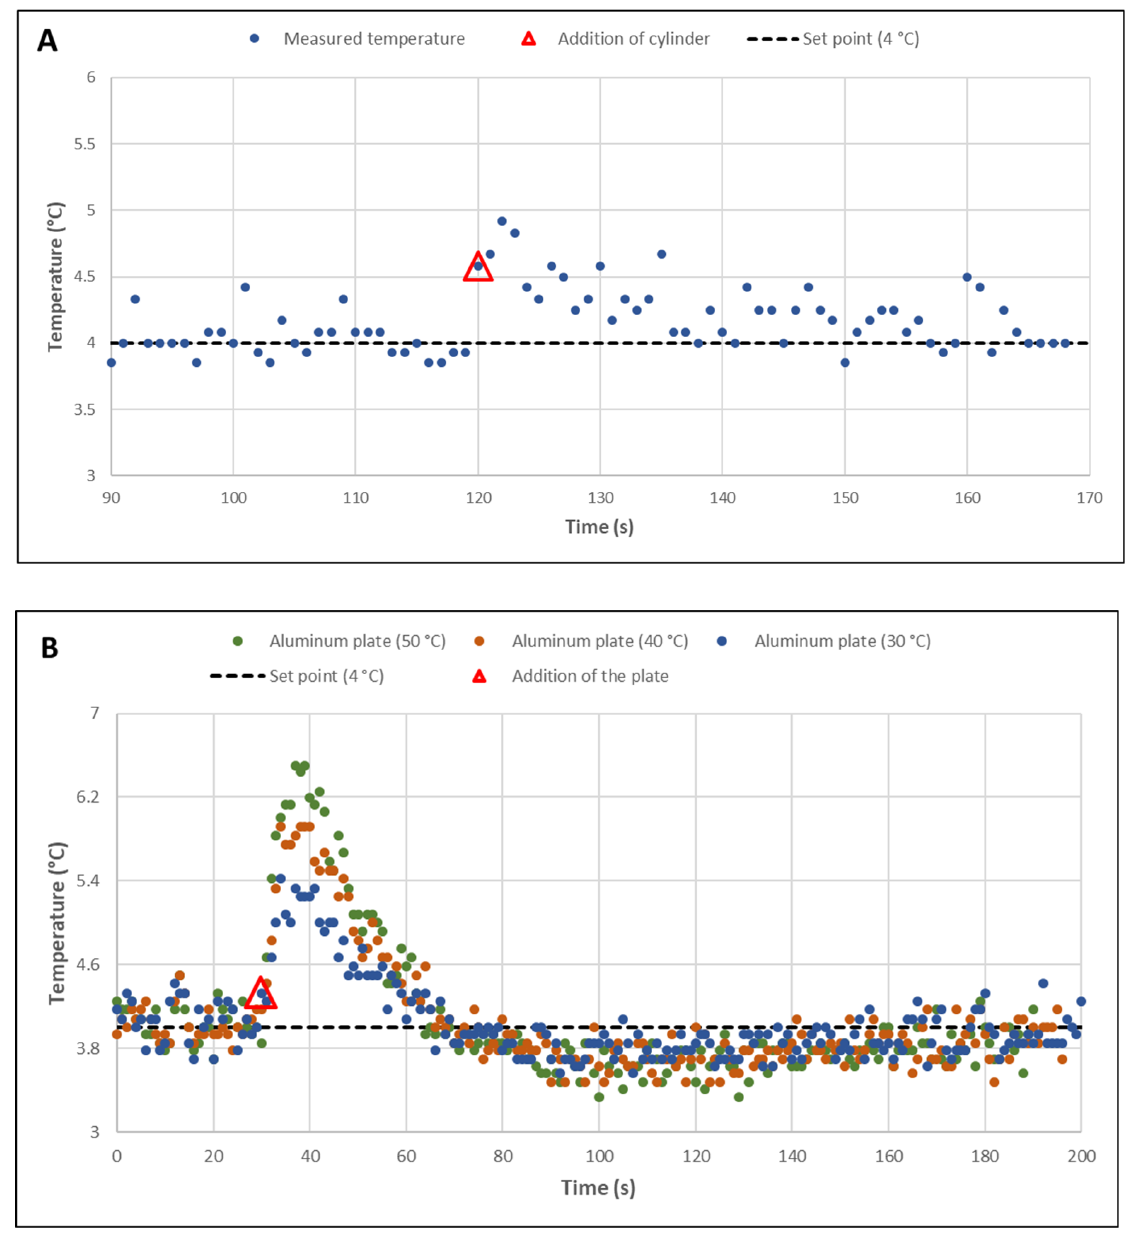
Figure 5. ( A ) Visualization of the temperature deviation from the setpoint after a hot gelatin cylinder (30 °C) 20 mm in diameter and 10 mm high was placed on the 16 cm 2 printing plate. ( B ) After placing an aluminum plate 2 mm thick and 16 cm 2 in cross section heated to 30 °C, 40 °C, and 50 °C on the printing plate.